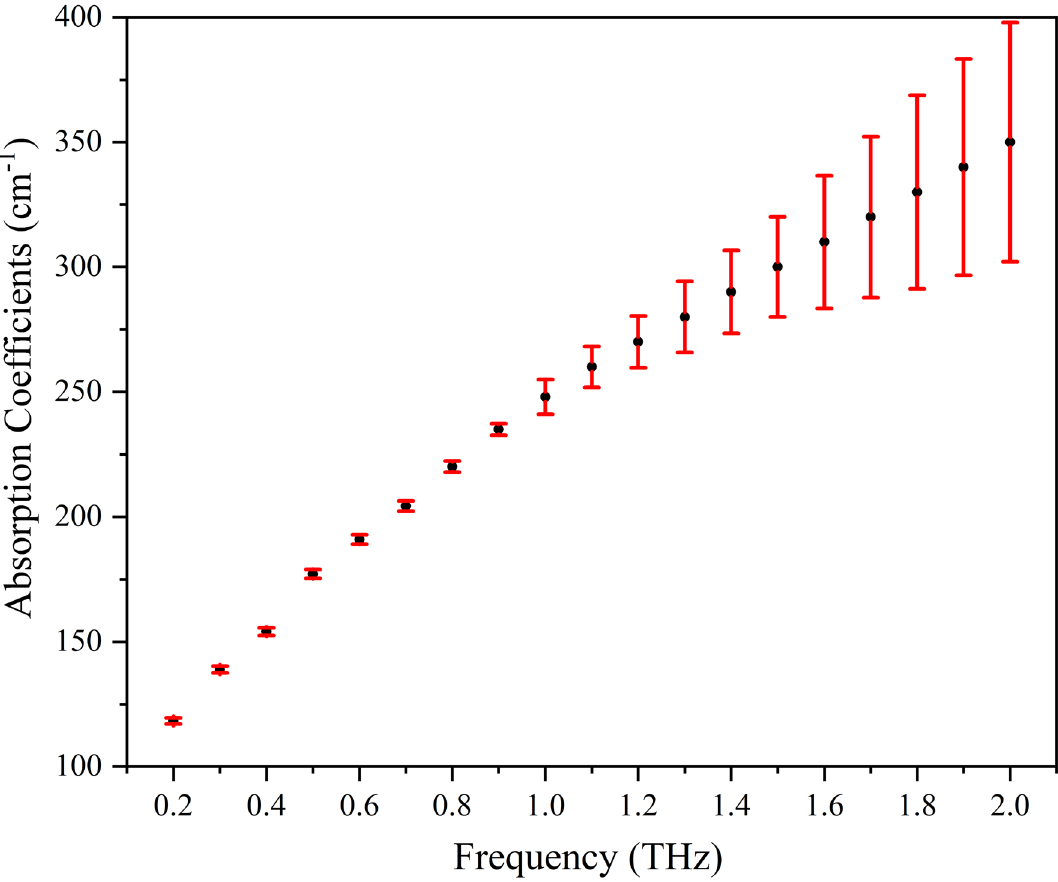
Figure 2. Five measured absorption coefficients of pure water. The red error bars represent the standard deviation of the mean, and the test number is